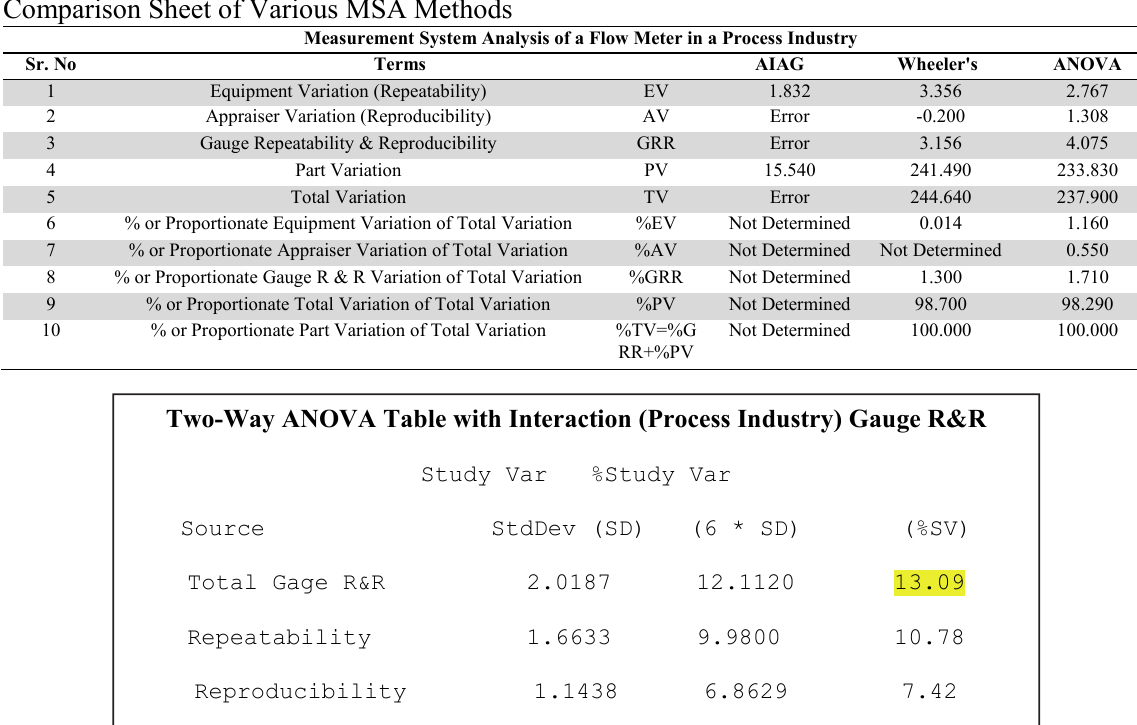
Fig. 4. ANOVA Calculation by Minitab (Process Industry)